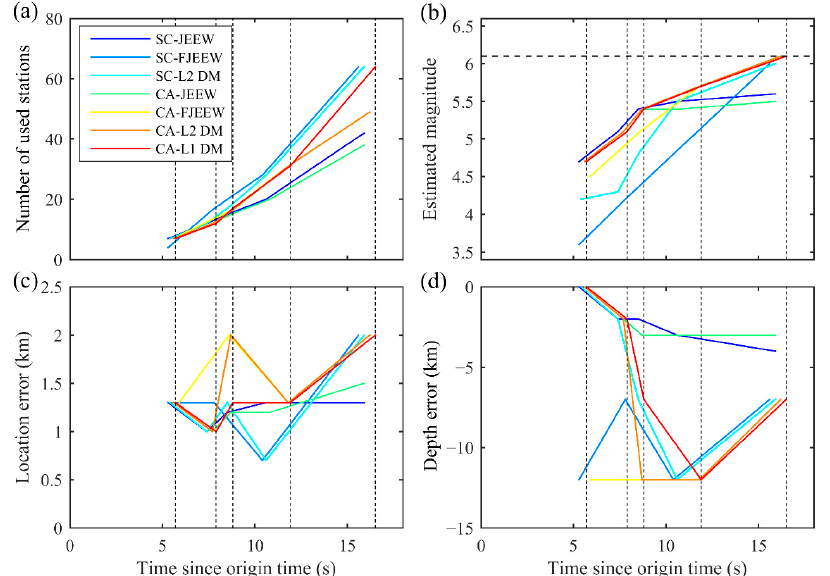
Figure 3. Real-time processing results of the Chinese national EEWS for the 2022 Lushan earthquake. ( a – d ) are the number of used stations, the estimated magnitude, the location error, and the depth error as a function of time, respectively. Vertical dotted lines represent alert times for the five reports. CA-L1DM, CA-L2DM, CA-JEEW, and CA-FJEEW are the L1-level Decision Module, the L2-level decision module, the JEEW system, and the FJEEW system deployed in the CENC processing center, respectively, while SC-L2DM, SC-JEEW, and SC-FJEEW represent the L2-level decision Module, the JEEW system, and the FJEEW system installed in the Sichuan processing center, respectively. Table 2. Detail information of the real-time processing results of the Chinese national EEWS for the 2022 Lushan earthquake. Definitions of CA-L1DM, CA-L2DM, CA-JEEW, CA-FJEEW, SC-L2DM, SC-JEEW, and SC-FJEEW are the same as those in Figure 3.